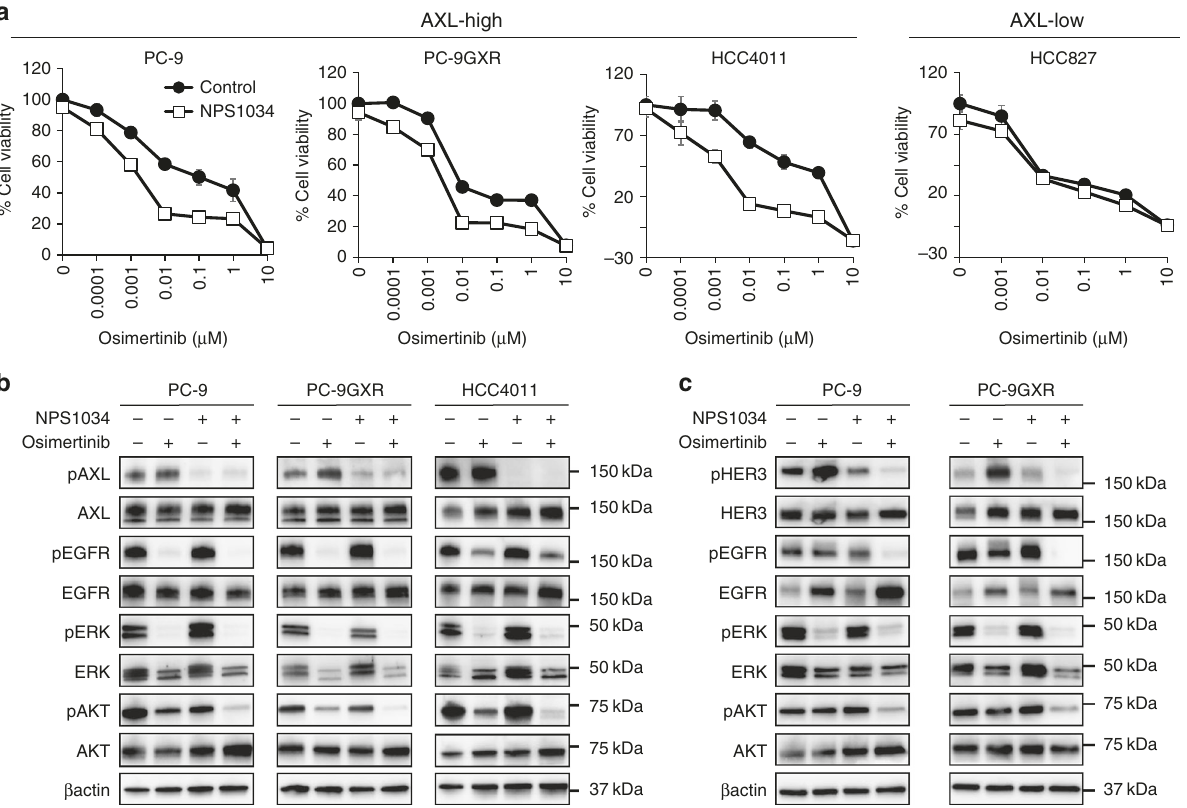
Fig. 4 AXL inhibitor sensitized AXL-high EGFR -mutant NSCLC cells to osimertinib. a PC-9, PC-9GXR, HCC4011, and HCC827 cells were incubated with osimertinib in the presence or absence of AXL inhibitor NPS1034 (1 μ mol/L) for 72 h and the cell viability was determined using MTT assays. Data are representative of three independent experiments that produced similar results. b , c The indicated cells were incubated with osimertinib (100 nmol/L) with or without NPS1034 (1 μ mol/L) for 1 h ( b ) and 72 h ( c ). The cells were lysed and the indicated proteins were detected by western